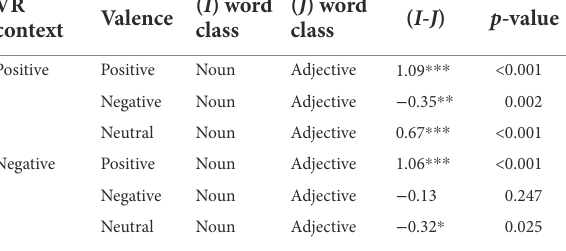
TABLE 2 Simple effects analyses of words selected in term of word